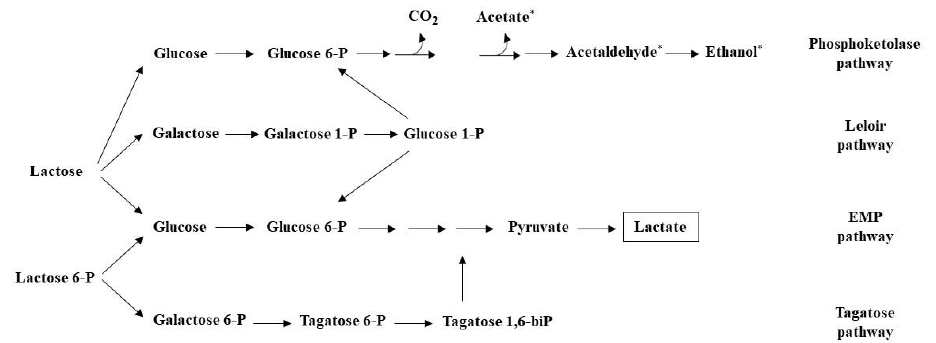
Figure 2. Schematic overview of carbohydrate catabolism pathways by LAB leading to the generation of flavor compounds in cheese. Asterisks denote flavor compounds [6,103,104].